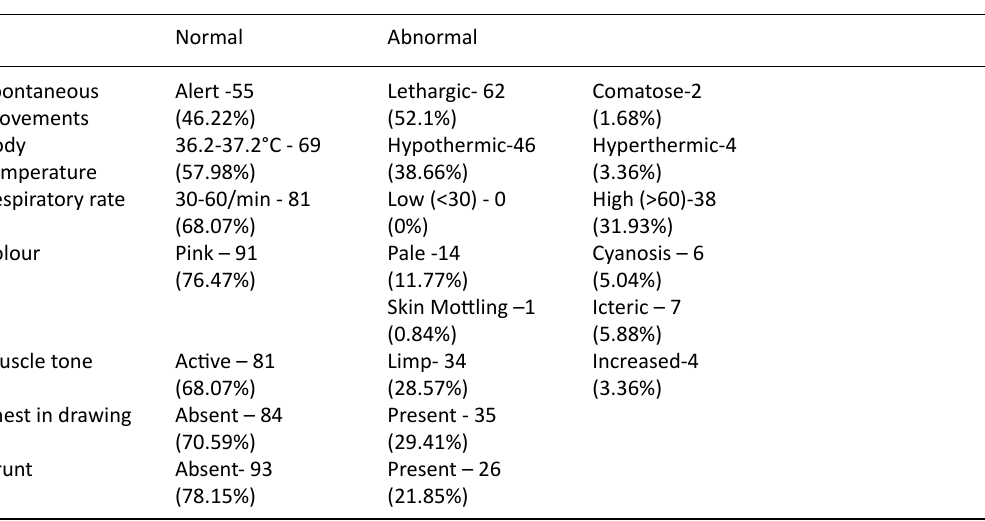
Table 4. Clinical profile of the patients Normal